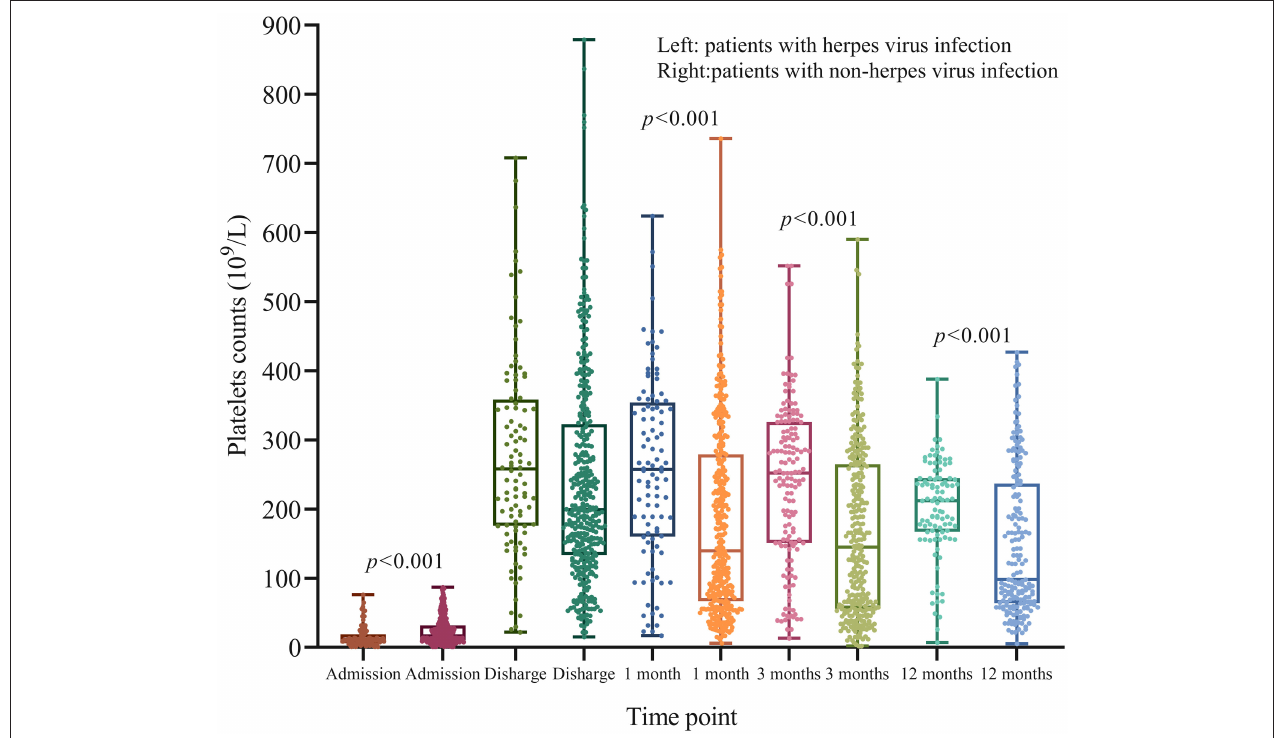
FIGURE 6 | Dynamic changes of PLT counts after treatment. At admission, patients with herpes virus infection had lower PLT counts compared to those without herpes virus infection ( p < 0.001). However, patients with herpes virus infection did not have lower PLT counts at 1, 3, and 12 months ( p < 0.001).